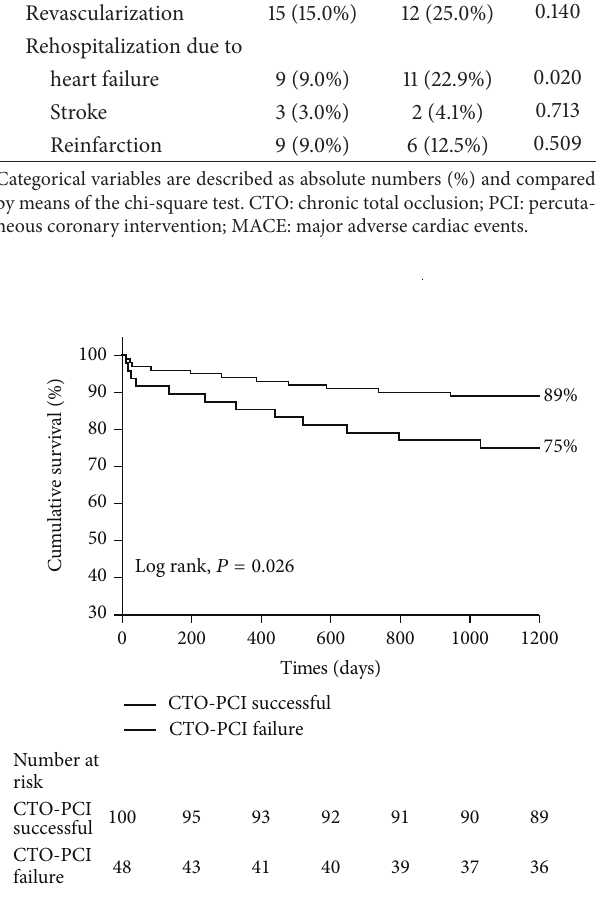
Figure 2: Cumulative survival at 3 years with respect to the outcome of attempted recanalization of a CTO in the non-IRA.